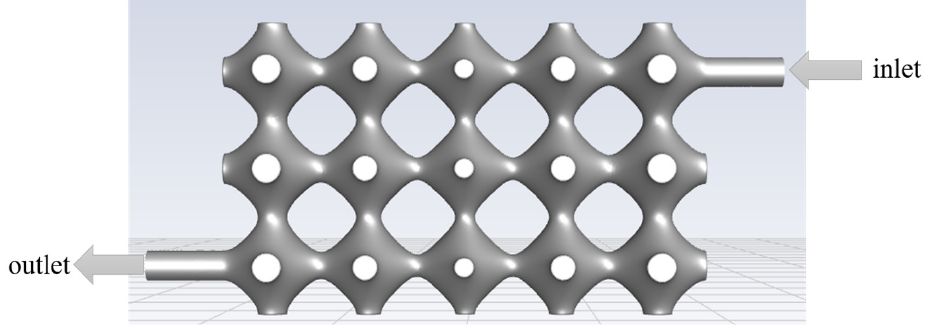
Figure 4. Fluid model entrances and exits. Table 1. Simulation parameter settings. Table 1. Simulation parameter